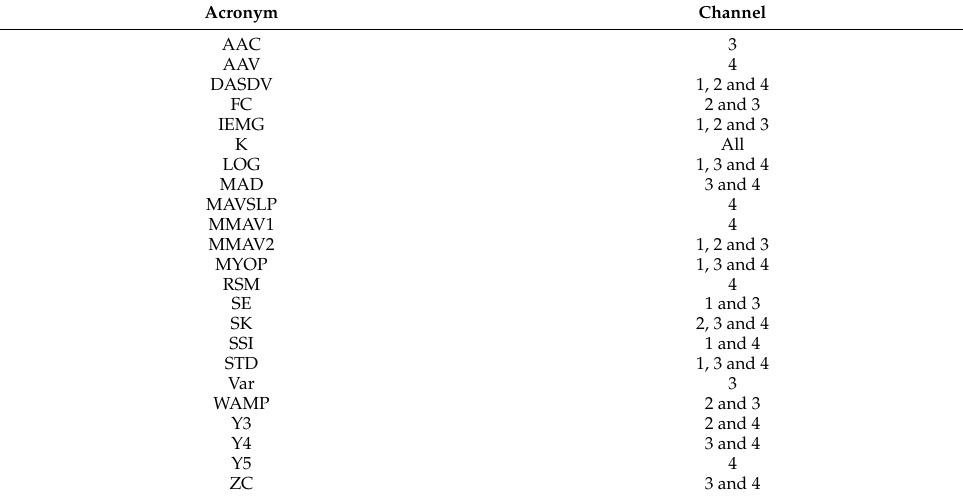
Figure 16. The number of features given by PSO using the SVM error as a fitness function for the various configurations. Table 17. Features selected as the best subset of characteristics for classifying signals from the right upper extremity using configuration 1 and PSO.